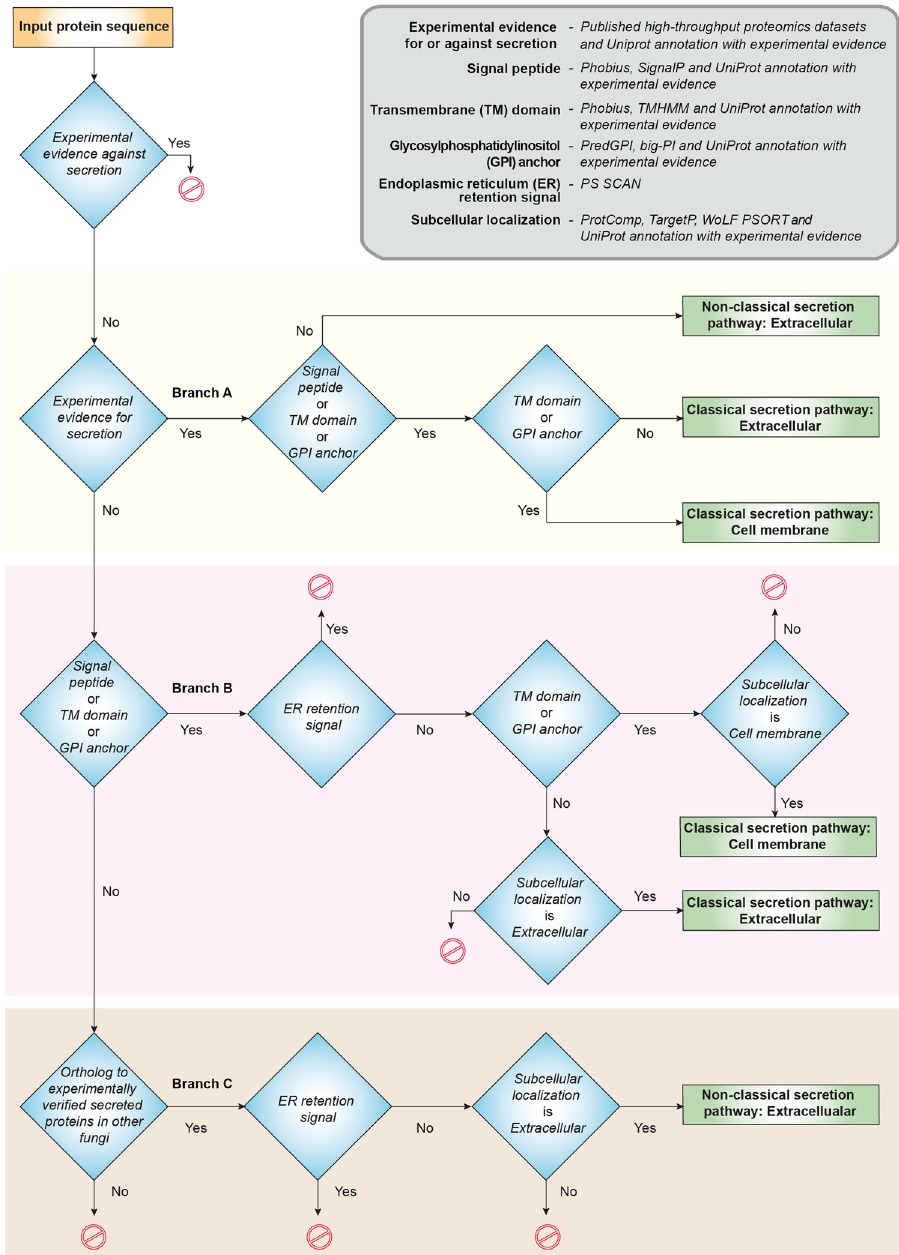
Figure 1. Flowchart of the computational prediction pipeline for identifying secreted extracellular proteins (secretome) and cell membrane proteins in Aspergillus species. Note that this prediction pipeline can be employed to identify secretome and cell membrane proteins in any fungi with sequenced